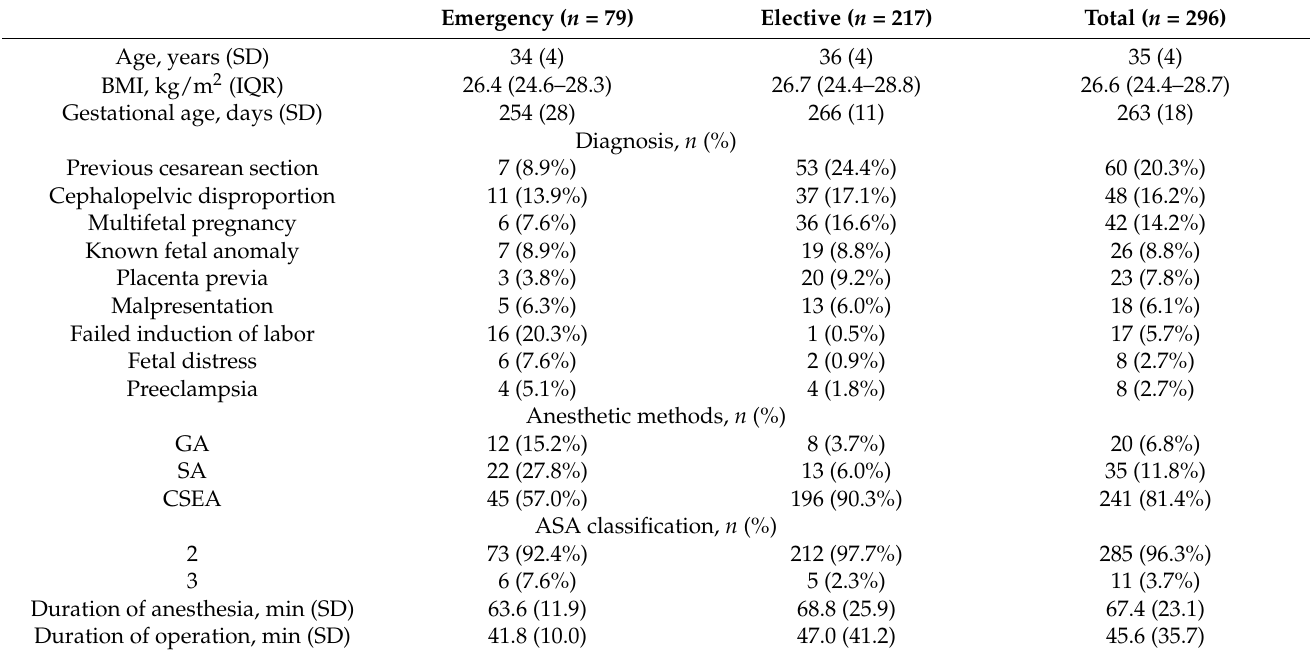
Table 1. Characteristics of the parturients.